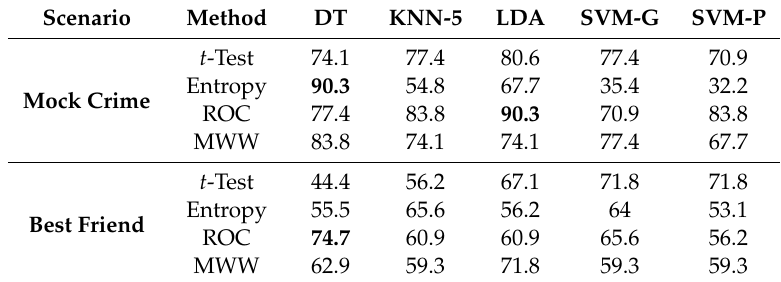
Table 3. Improvement of classification accuracy by employing four feature ranking methods in mock crime and best friend scenarios, respectively. The results reported by highest ranked features of thermal